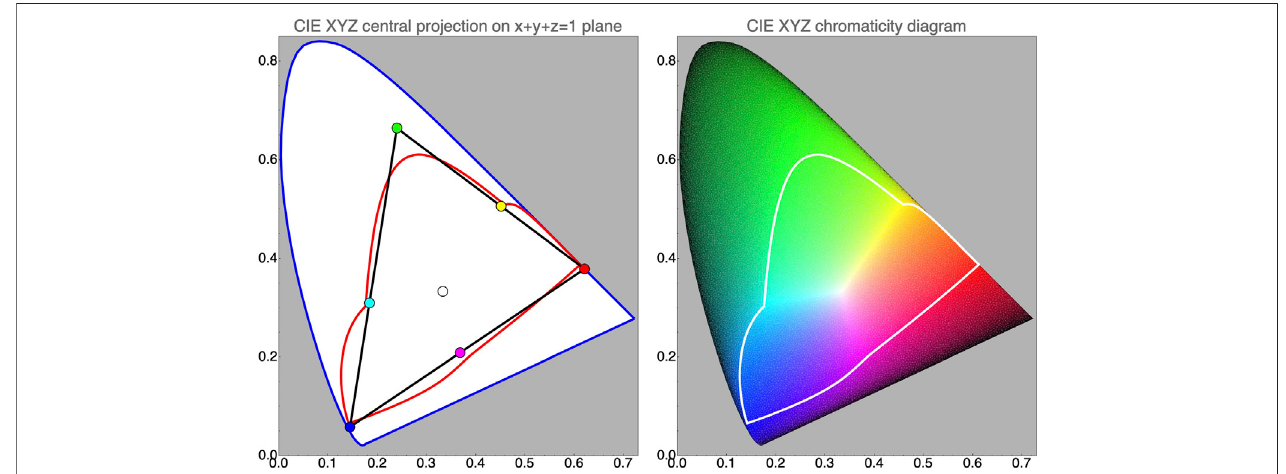
FIGURE12| Atleft theCIE – xy-chromaticitydiagram, withthegamutsofthetripartition and oftheOstwald semichrome basis. Theblack triangleshowsthe outline of the RGB cube. The red line indicates the semichrome locus. Note how the outlines mutually intersect. At right the CIE diagram with colors of the optimal color coloring. The “ best ” colors are located near the semichrome locus, the central location is white, the spectral boundary and the line of purples are black. That is because the boundary of the diagram is the image of the origin of color